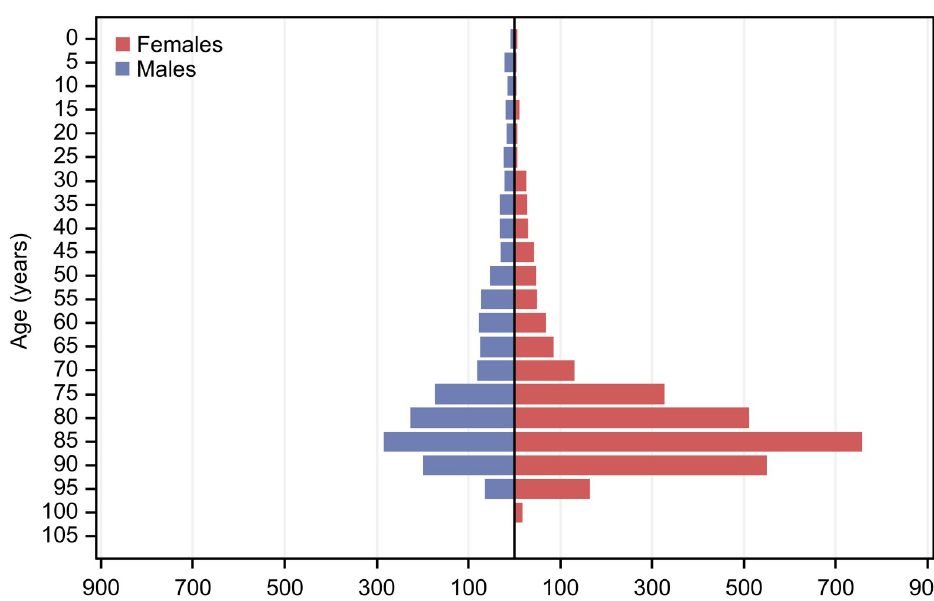
Fig 1. Age distribution for males and females among all patients who requested health care allowances in 2017 and 2018 in Austria because of a diagnosis-related minimum classification of visual impairment, blindness or